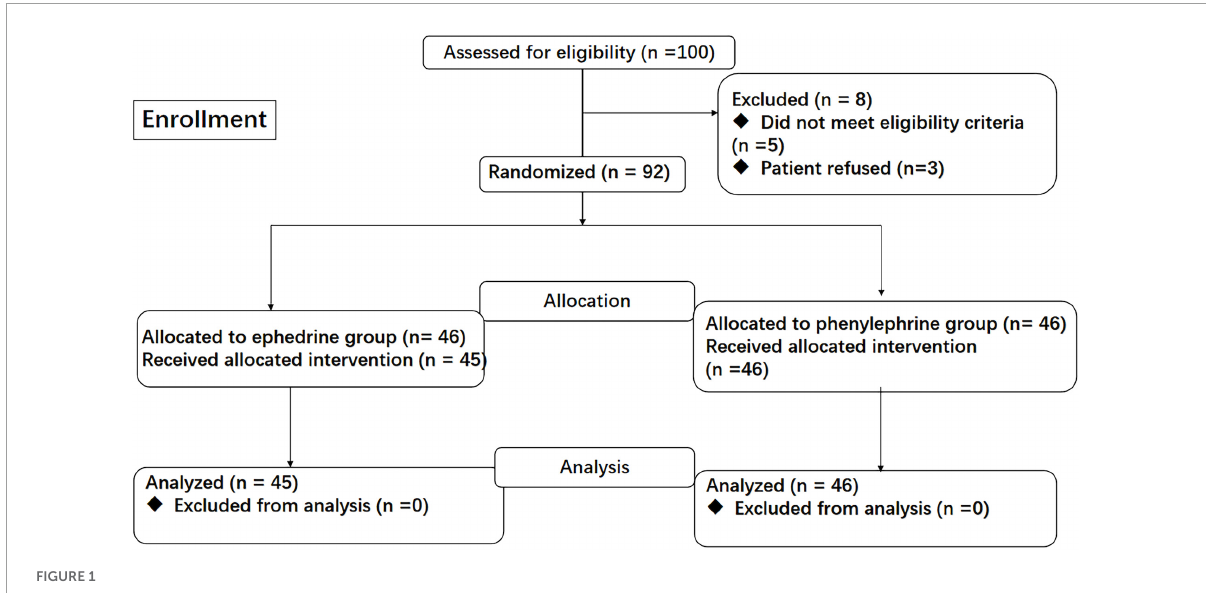
FIGURE1 CONSORT flow chart.